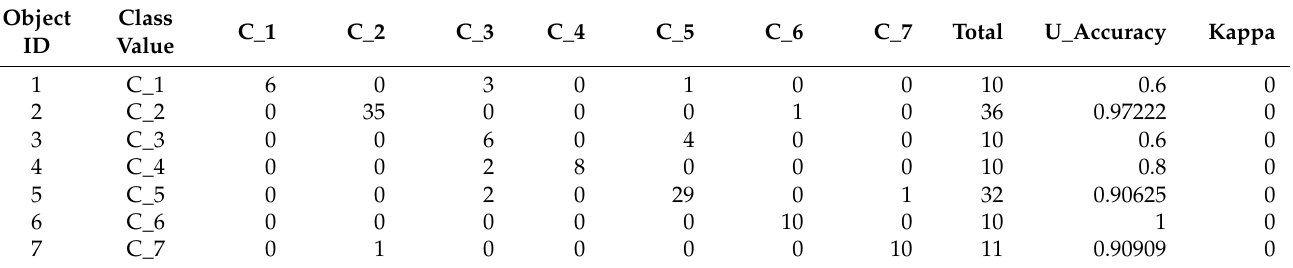
Figure 7. The classification of impervious surfaces using SVM, ML and RT methods. (Source: own elaboration based on orthophoto maps available on Geoportal—https://www.geoportal.gov.pl/, accessed on 2 November 2022). Table 1. Confussion Matrix (SVM